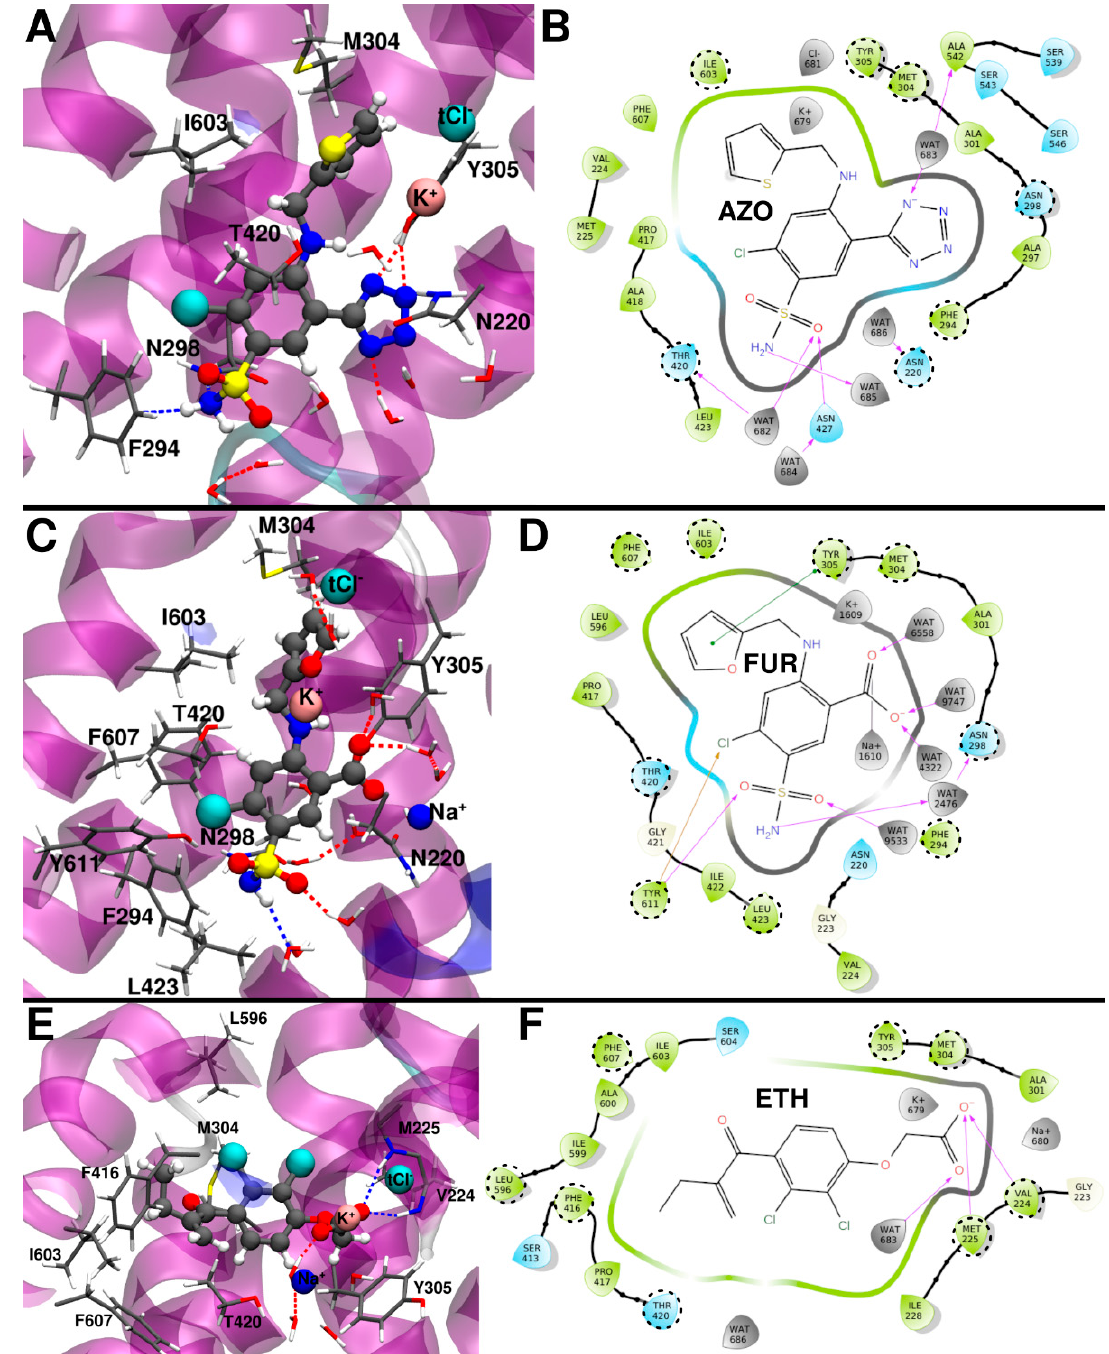
Figure 4. ( A ) Binding mode of azosemide (AZO) from the representative structure of the most populated cluster extracted from the molecular dynamics (MD) trajectory. ( B ) 2D schematic representation of the AZO/zNKCC1 interactions. ( C ) Binding mode of furosemide (FUR) from the representative structure of the most populated cluster extracted from the MD trajectory. ( D ) 2D schematic representation of the FUR/zNKCC1 interactions. ( E ) Binding mode of ethacrynic acid (ETH) from the representative structure of the most populated cluster from the MD trajectory. ( F ) 2D schematic representation of the ETH/zNKCC1 interactions. Polar/charged protein residues are colored blue, while the others are colored green. Waters and ions are colored gray. The most important protein residues, identified by alanine scanning analysis, are highlighted in dashed circles.